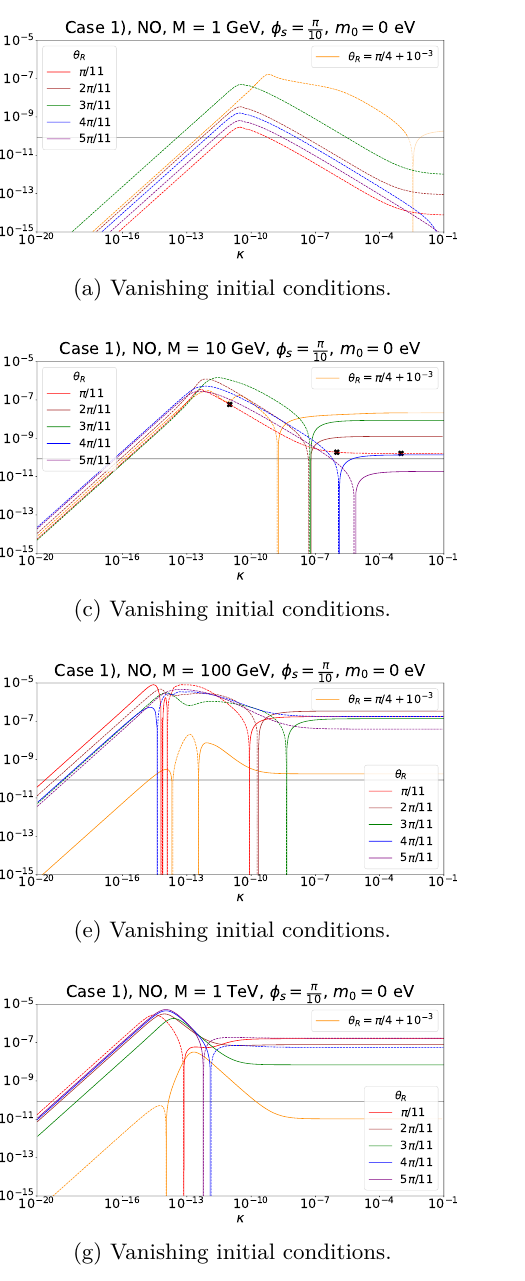
Figure 4 . Case 1) BAU ( Y B ) as function of the splitting κ for a Majorana mass M = 1 GeV, M = 10 GeV, M = 100 GeV and M = 1 TeV for both vanishing (left plots) and thermal initial conditions (right plots). For each of these choices, different values of the angle θ have been studied. R Light neutrino masses have strong NO. The index n of the flavour group is n = 10 . The parameter . Both negative (dashed lines) as well as positive s is fixed to s = 1 corresponding to φ s = π 10 (continuous lines) values of the BAU are represented. The grey line indicates the observed value of the BAU, Y 8 . 6 · 10 − 11 . The black crosses in plot (c) refer to particular choices of θ and κ that B ≈ R are used as reference values in some of the following plots, e.g. in figure 7. The choice θ = π + 10 − 3 R 4 (orange curve) corresponds to a value of θ close to a special value, for details see text. Faint lines R indicate that the condition in eq. (3.69) is not